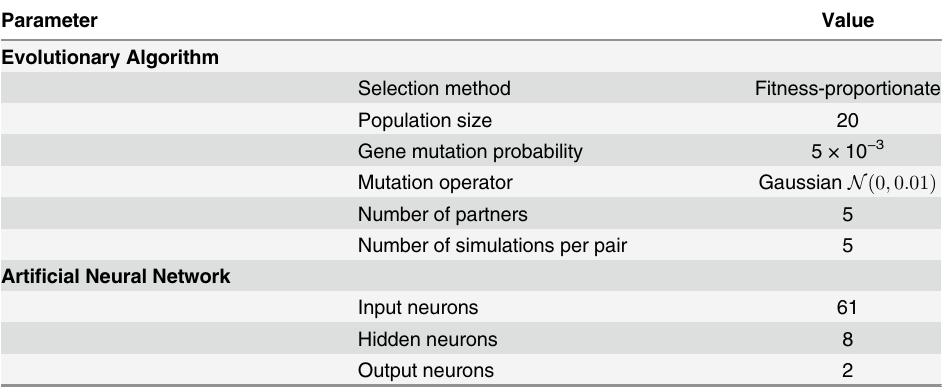
Table 2. Simulation